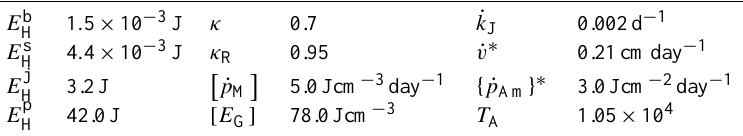
Table 1. DEB model parameters used in the simulations. The parameter values are taken from Augustine et al. (2014); ∗ denotes parameters < E H < E j which increase by a factor 8.6 during metabolic acceleration (i.e. E s ). The values are given at a reference temperature of 20 ◦ C. H H We refer the reader to Fig. 2 and to the original study (Augustine et al., 2014) for the physiological interpretation of the parameters. E b